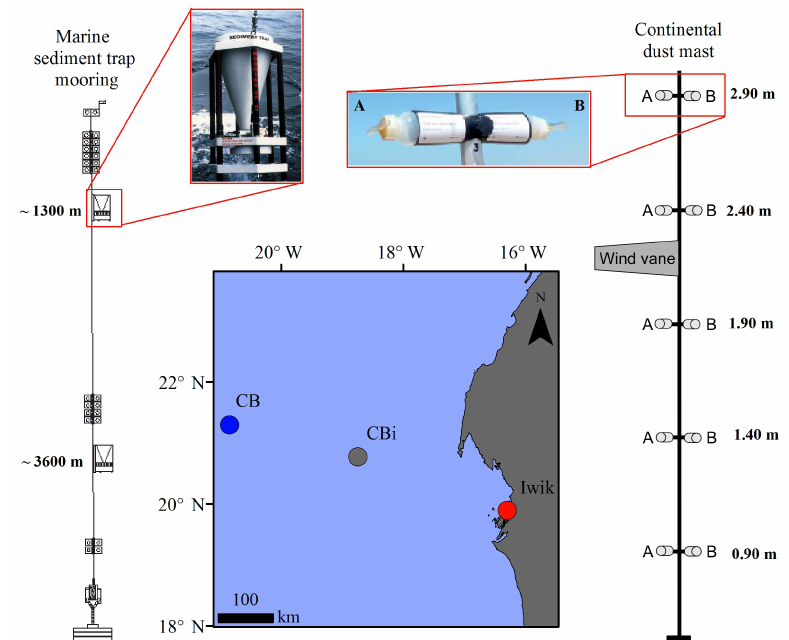
Figure 2. The marine sediment trap moorings CB and CBi off Cap Blanc and the dust masts near Iwik, Mauritania. On the left, a sketch of the sediment trap mooring (sketch of CB 24 copied from Fischer et al., 2013) together with a photograph of the trap (downloaded from www.kum-kiel.de) is displayed. On the right, a sketch of the dust mast together with a photograph of the MWAC sampling bottles is depicted. Table 3. Sediment trap (CBi) and MWAC samples (Iwik) chosen for mineralogical investigation. Sample Sampling period Mast Bottle Elevation/water Sampling depth (m) interval CBi 11 upper no. 25 Jun–16 Jul 2013 – – 1406 21 8